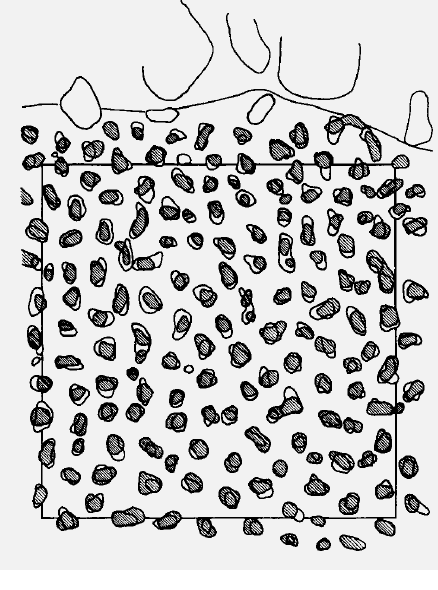
Figure 5 - Camera lucida draw- ings of NADPH-diaphorase-posi- tive neurons from different cor- tical layers of V1 gray matter as seen in a parasagittal section. Although their dendritic arboriza- tion seems quite variable, none of the cells are pyramidal. Supra- granular layer neurons (A,B), layer 4C neurons (C), and a neu- ron from layer 5 (D) are illus- trated. The arrows point to